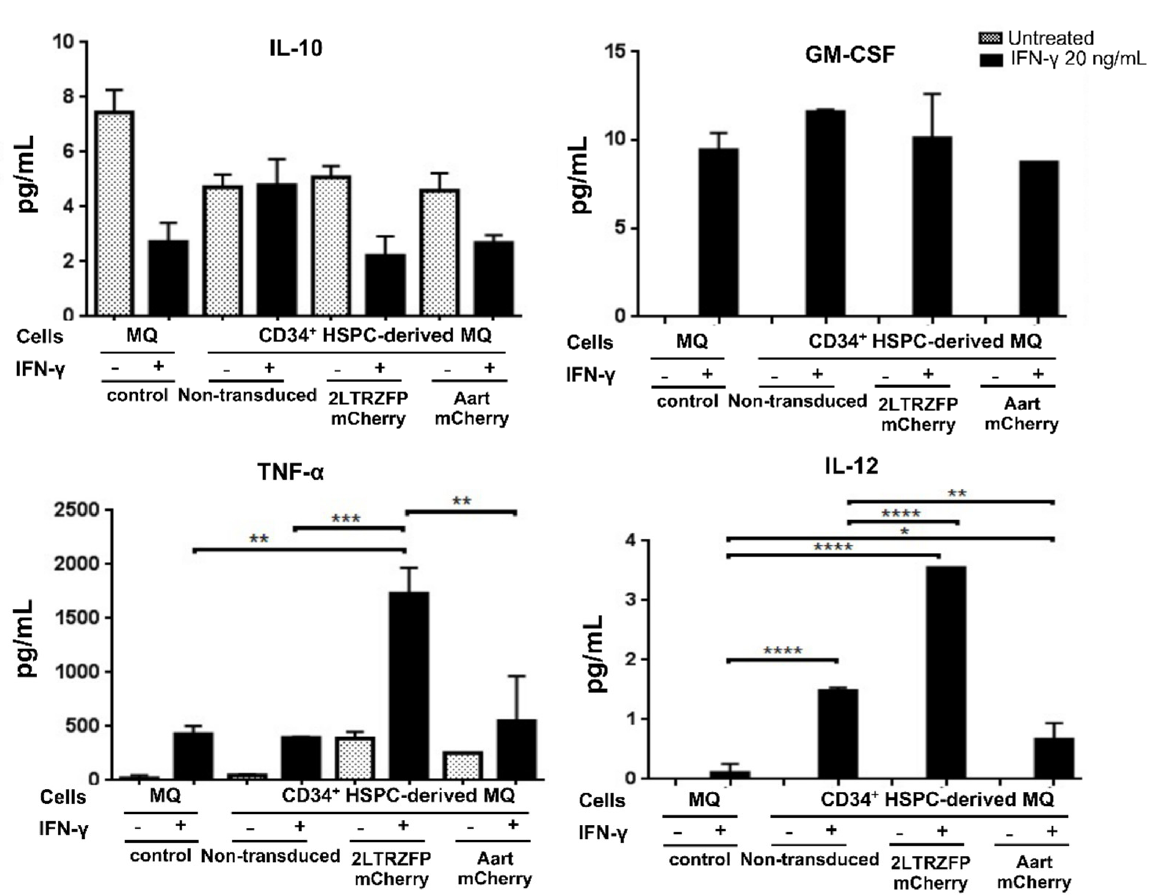
Figure 5. Cytokine secretion profiles of transgenic CD34 + derived macrophages. The non ‐ trans ‐ duced, AartmCherry, and 2LTRZFPmCherry transduced macrophages derived from CD34 + HSPCs, and PBMC monocyte ‐ derived macrophages were stimulated with IFN ‐γ . At 24 h post ‐ stimulation, supernatants were collected and assayed by cytokine bead array. Experiments were performed in duplicate. * p < 0.05, ** p < 0.01, *** p <0.001, and **** p < 0.0001 from one ‐ way ANOVA analysis. MQ = macrophages.